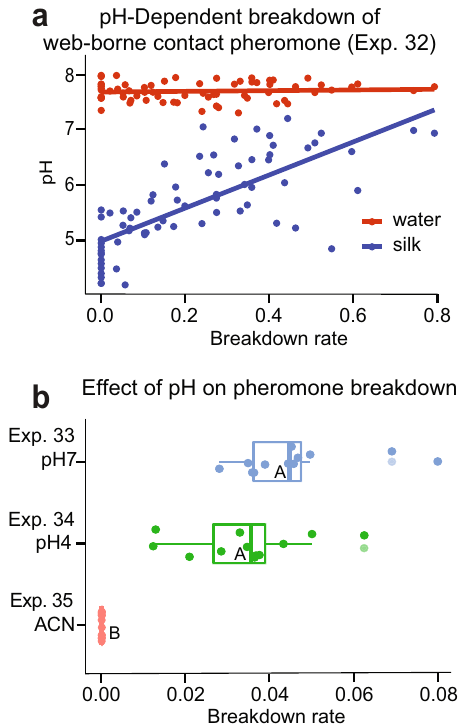
Fig. 5 pH-Dependent breakdown of contact pheromone components. a Relationship between the pH of female Steatoda grossa webs and the breakdown rate of contact pheromone components 12 , 16 , and 17 , calculated as the ratio of 18 /( 12 + 16 + 17 + 18 ) (in blue); control measurements of the water ’ s pH are displayed in red. b Effect of pH on the breakdown of synthetic contact pheromone component 12 , calculated as the ratio of 18 /( 12 + 18 ). Circles and boxplots show the breakdown rate of each sample and the distribution of data (minimum, fi rst quartile, median, third quartile, maximum), respectively, at pH 4 and pH 7; medians with the same letter indicate no signi fi cant difference in breakdown rates (Kruskal – Wallis test; P < 0.05). Note the different scales of the x-axis in subpanels a and b ; 12 = N -4-methylvaleroyl- O -isobutyroyl- L -serine; 18 = N - 4-methylvaleroyl- L -serine (amide), ACN